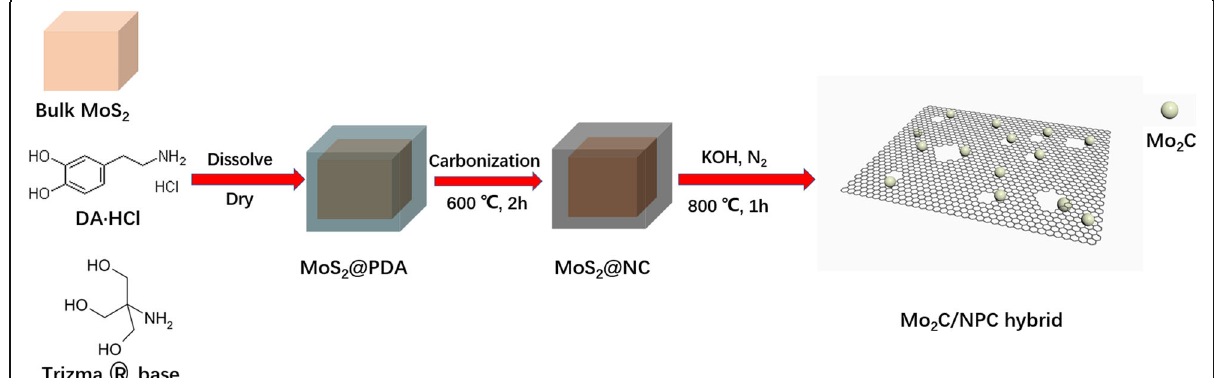
Fig. 1 Schematic of the procedure for preparation of Mo 2 C/NPC hybrid